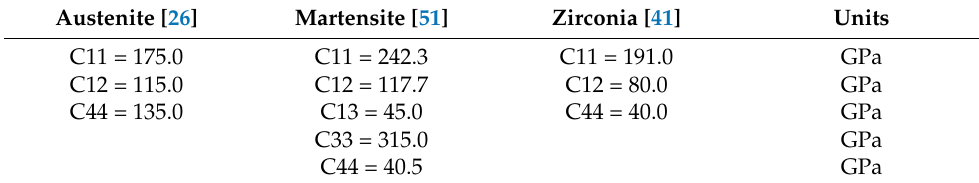
Table 2. Single-crystal elastic constants for Austenite, Martensite, and Zirconia incorporated in the model during simulations. The table has been adapted from a previous publication [28] and is being reprinted with the permission of